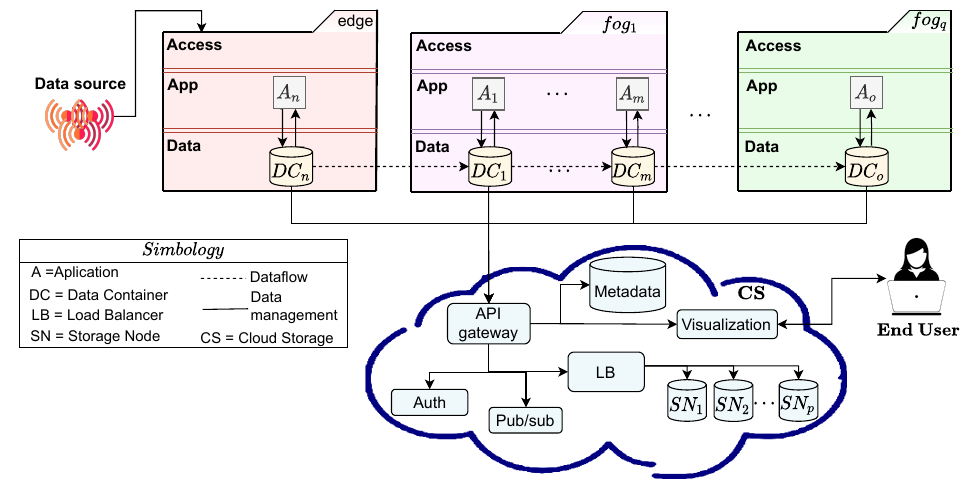
Figure 3. Efficient data delivery scheme for the